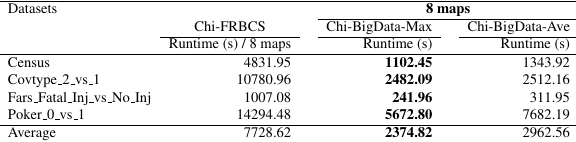
Table 5. Average runtime elapsed in seconds for the Chi- FRBCS versions supposing that the sequential version was ex- ecuted in parallel